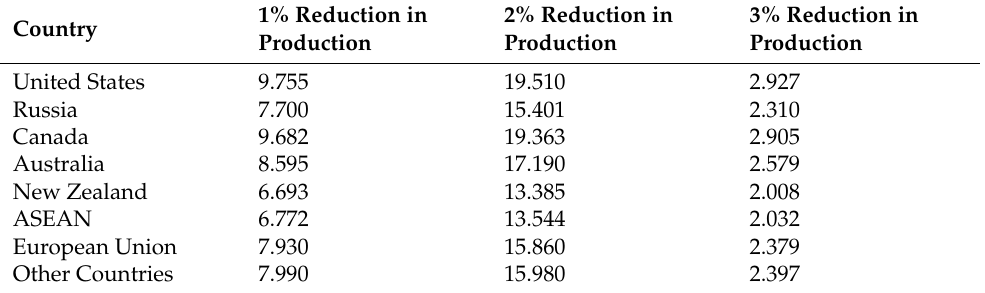
1% Reduction in Production